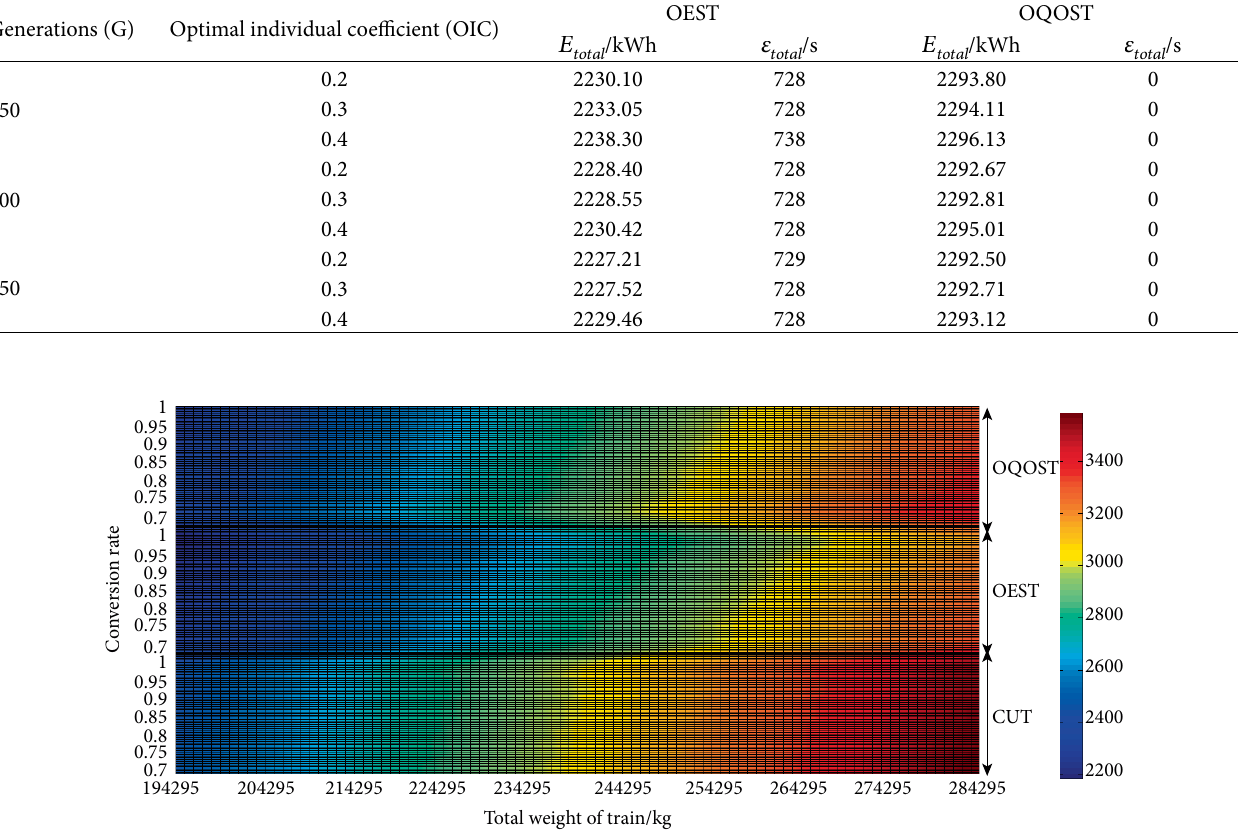
Figure 24: A comparison between the main parameters and total energy consumption under different